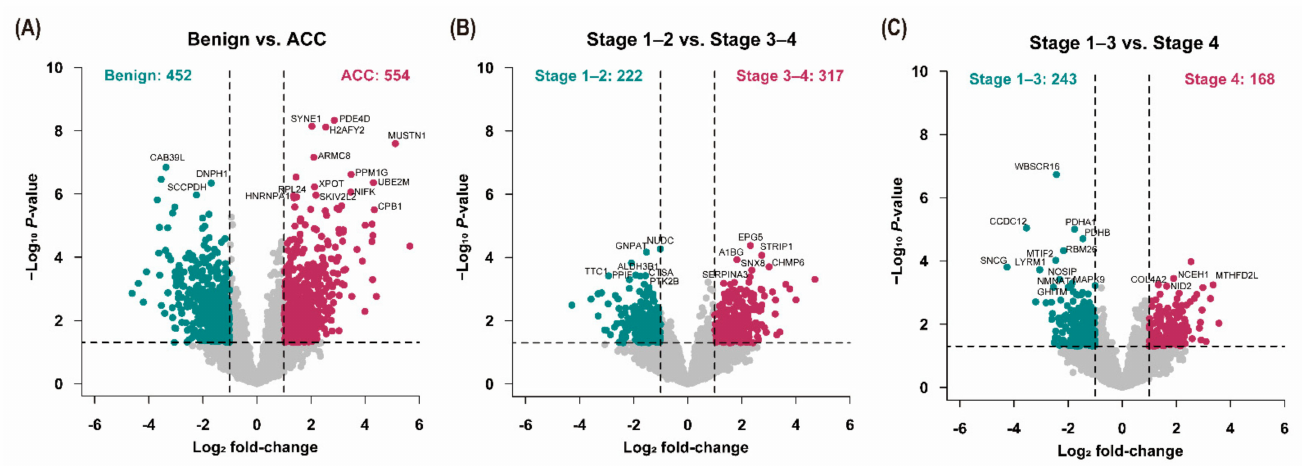
Figure 2. Volcano plots for differential expression of proteins. Volcano plots showed significantly differentially abundant proteins. The − log 10 ( p -value) is plotted against log 2 (fold-change). The non-axial vertical lines denote a two-fold difference in expression, while the non-axial horizontal line denotes p = 0.05, which is our significance threshold. The differential expression of proteins in ( A ) benign adrenal adenomas and ACC, ( B ) stages 1–2 and 3–4 ACCs, and ( C ) stages 1–3 and 4 ACCs is expressed, respectively. ACC—adrenal cortical